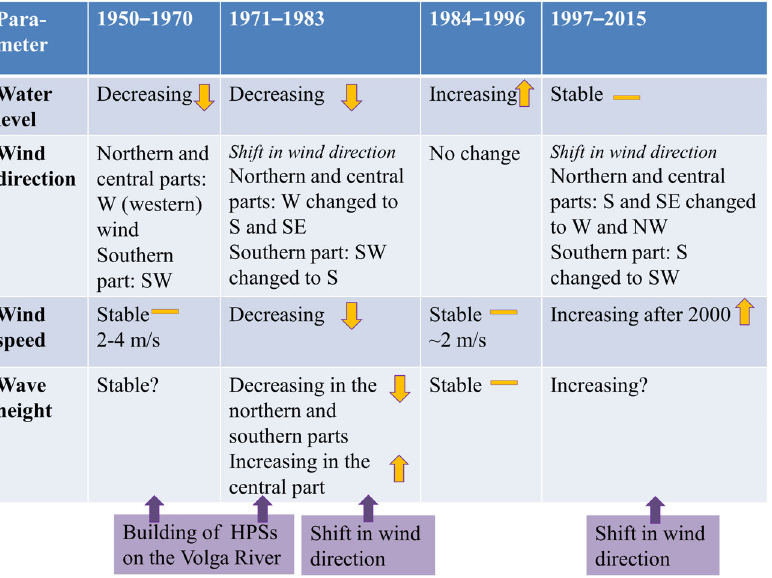
Fig. 2. A summary of changes in hydrometeorological conditions in the Caspian Sea region in 1950–2015, following Yaitskaya